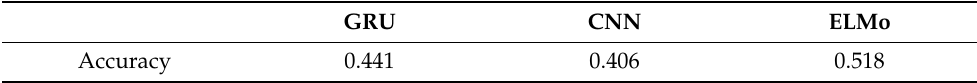
Table 6. Accuracy when translating AI hub dataset to English.